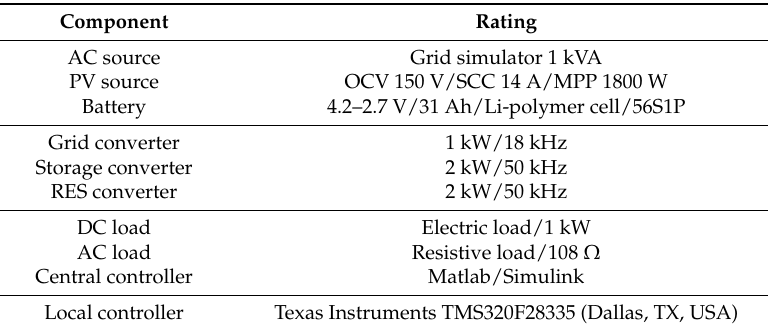
Table 3. Specifications of experiment set-up.